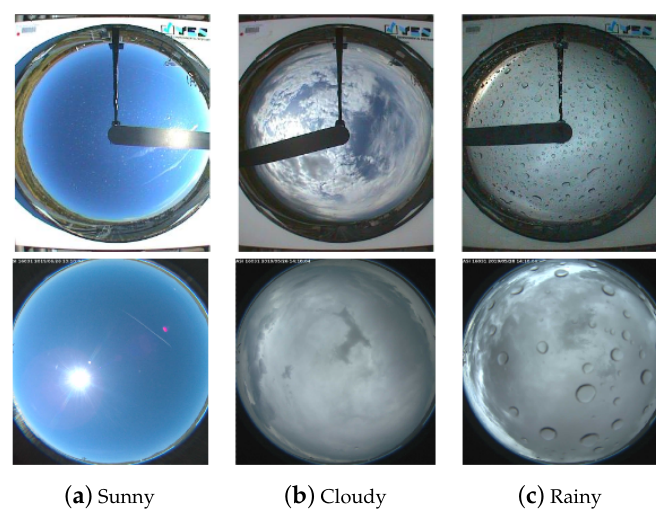
Figure 1. Sky images for three types of weather conditions from the TSI-880 ( top ) and ASI-16 ( bottom )